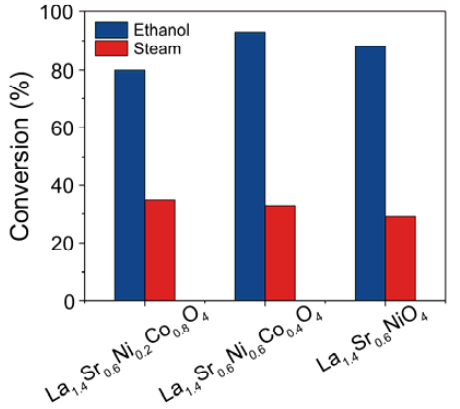
Figure 6. Ethanol and steam conversion in the fuel feed step.